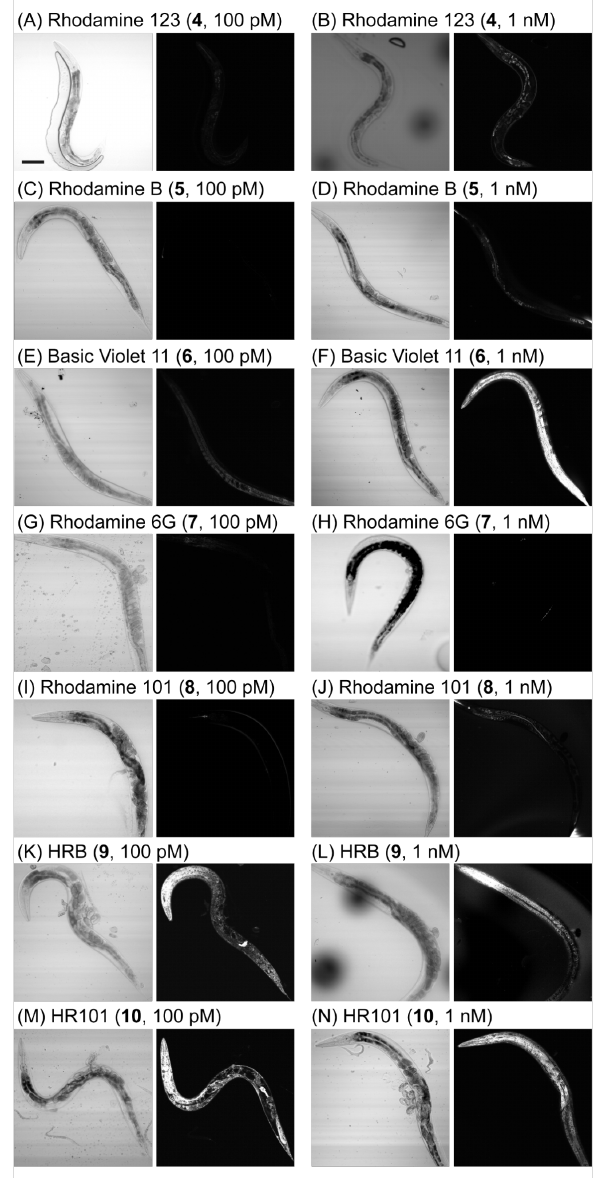
Figure 4: Differential interference contrast (DIC, left panels) and confocal laser scanning (right panels) micrographs of living C. elegans (20× objective) treated with synthetic compounds for 2 h followed by transfer to an imaging pad containing polystyrene beads for immobili- zation. The weak signal observed with rhodamine 123 at 1 nM (panel B) was independently identified as autofluorescence of the intestine. Animals are oriented with the anterior end (head) to the left and the ventral side (base) down and/or toward the left. Scale bar = 100